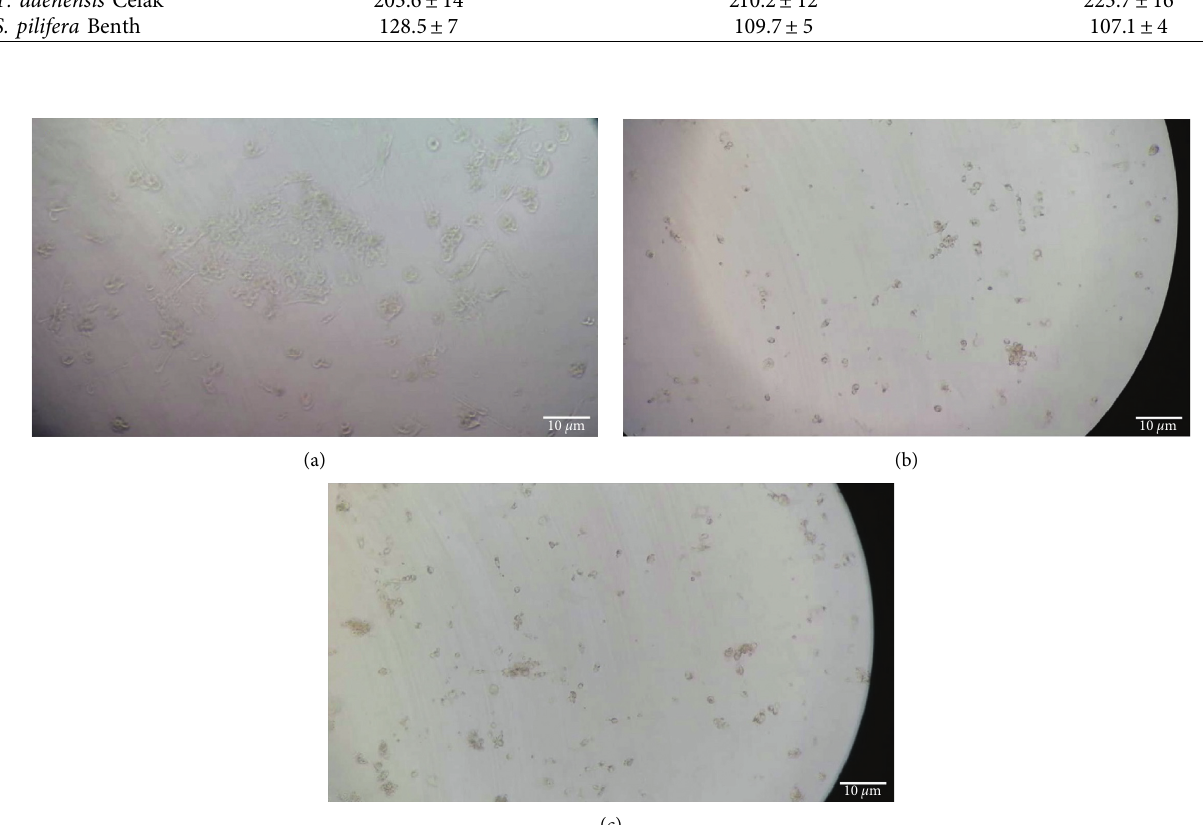
Figure 2: Optical microscope images of HepG2 cell lines. (a) Untreated. (b) Treated by 500 µ g/ml TDC. (c) Treated by 500 µ g/ml SBP plants extracts. Firstly, 8 × 10 3 cells per well were seeded in a 96-well plate and incubated for 24 hours, after that treated by plant extracts. The assay was repeated three times. Scale bar � 10 µ